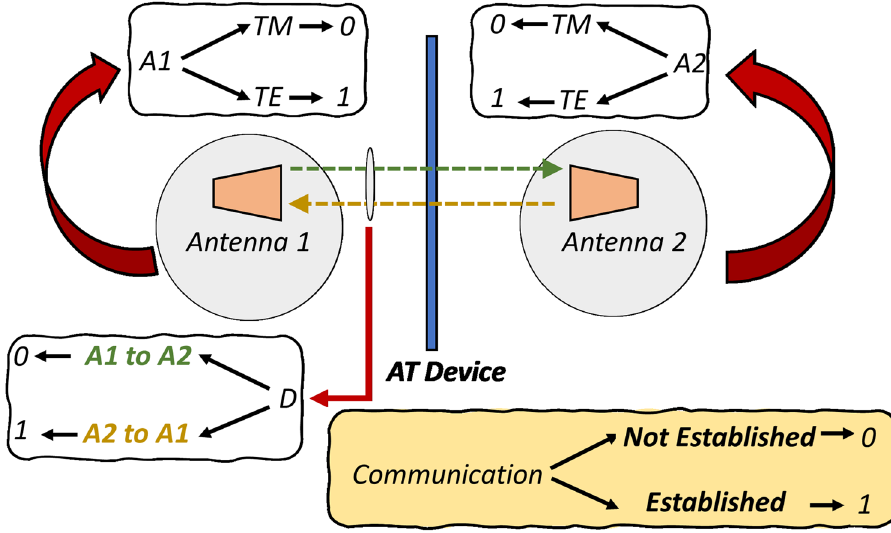
Figure 1. Modeling of logic gates analogy of AT operation.